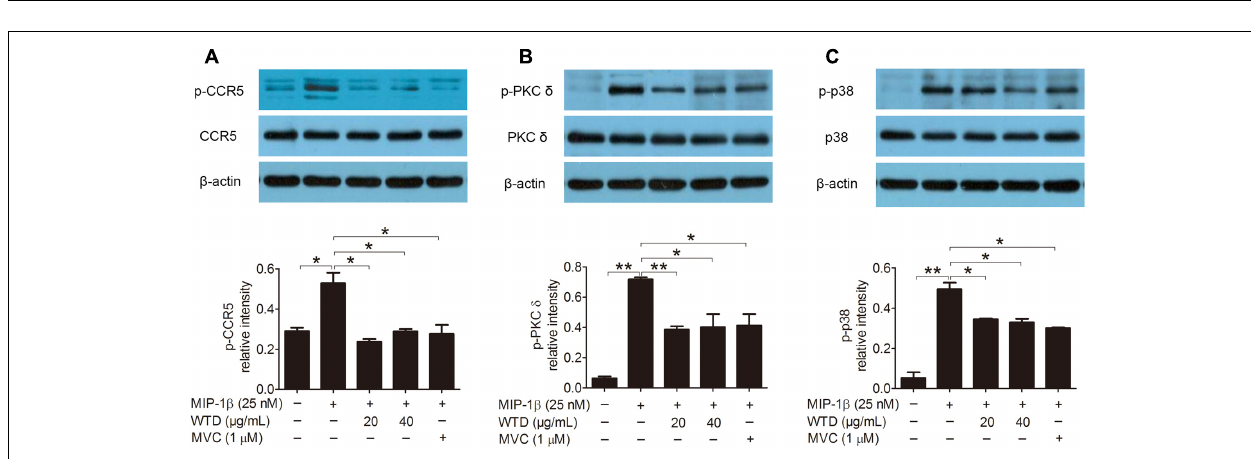
FIGURE 3 | Inhibition of total and phosphorylation levels of CCR5, PKC δ , and p38 in MIP-1 β -induced U937 cells by WTD. Cells were pre-treated with PMA for 48 h and then incubated with or without WTD or MVC for 2 h. Subsequently, cells were stimulated with MIP-1 β (25 nM). After 10 min of stimulation, cells were collected to detect total and phosphorylated (p) CCR5 (A) , PKC δ (B) , and p38 (C) by western blotting. ∗∗ P < 0.01, ∗ P < 0.05.